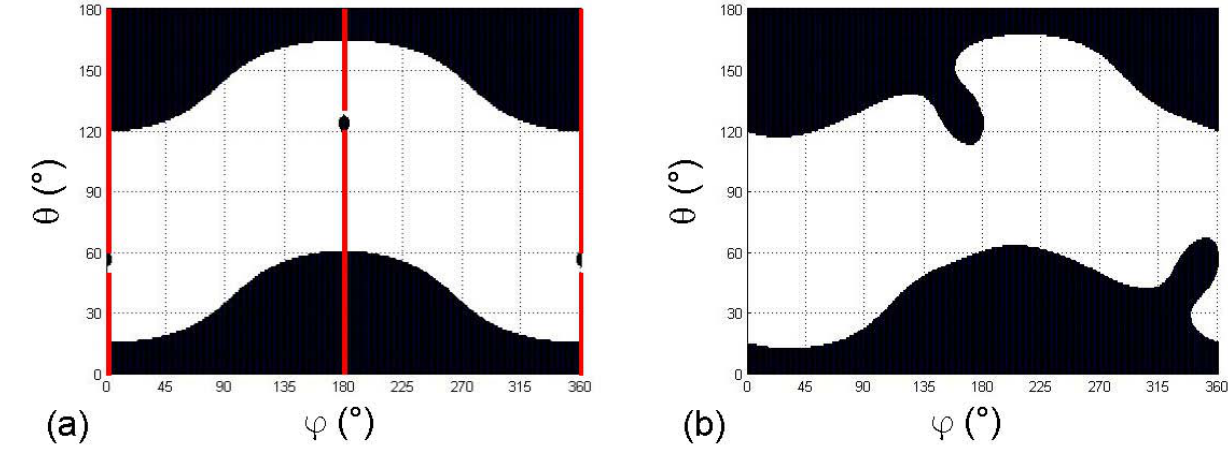
Figure 3. Black area showing spherical angles coordinates of inversion zones. (a) Inversion zones related to the absorption angular distribution at 812 nm in the real-life monoclinic YCOB:Nd crystal. Red full lines stand for XZ plane ( ϕ = 0° , 180°, 360° ) when this dielectric plane is a symmetry mirror. (b) Possible inversion zones for a theoretical triclinic